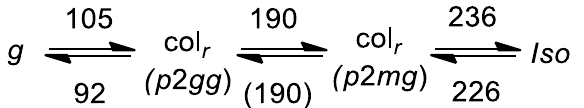
) at 180 ◦ C and the solid state ( g ) at 20 ◦ C ( ∆ ) of KSCN-2b . (cid:35)